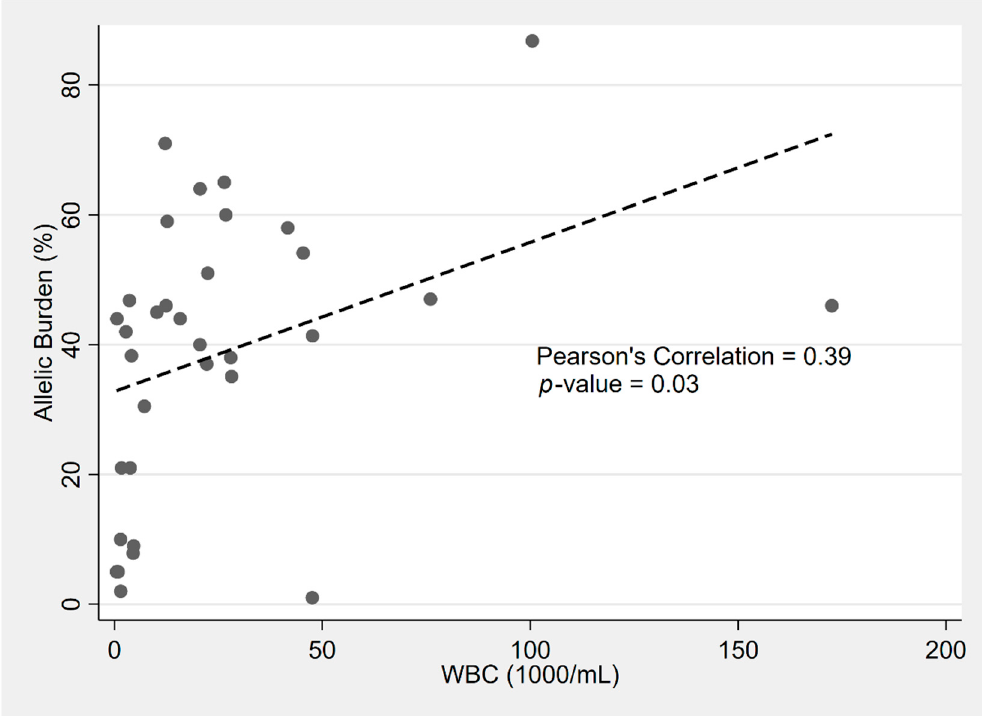
Figure 1. Distribution of FLT3 -ITD allelic burden (%) and associated WBC count (×10 9 /L) at diagnosis per patient in FLT3 -ITD APL. FLT3 -ITD